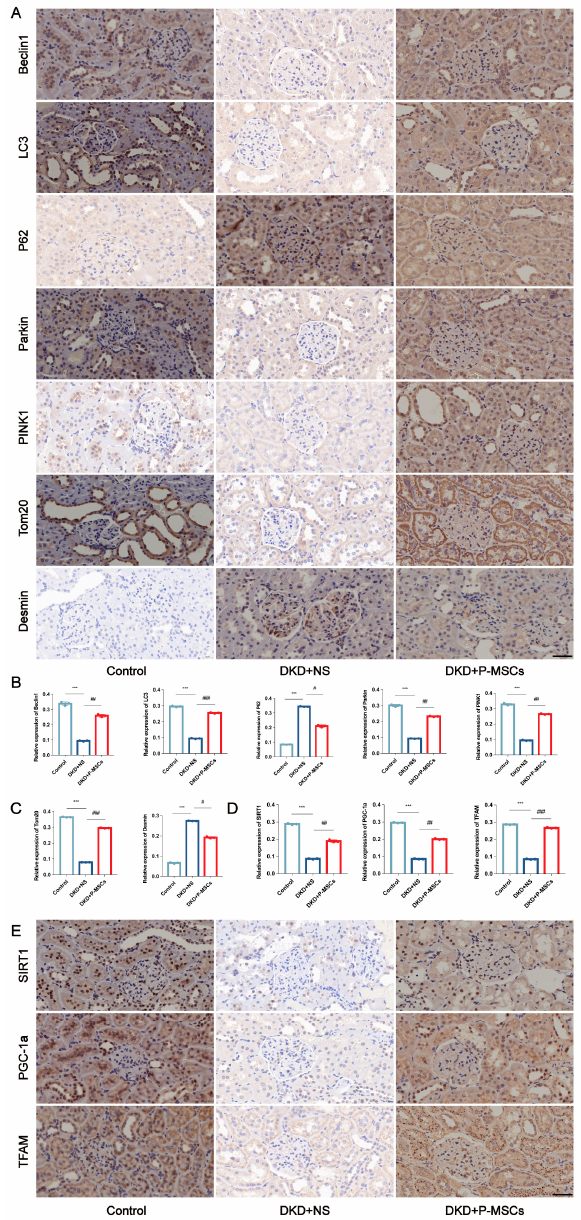
Figure 8. P-MSCs ameliorated STZ-induced podocyte injury and PINK1/Parkin-mediated mitophagy in DKD rats. ( A – C ) Immunohistochemical analysis of Beclin1, LC3, P62, Parkin, PINK1, and Tom20, as well as Desmin in DKD rats (Magnification, 400 × ). ( D , E ) Immunohistochemical analysis of SIRT1, PGC-1a, and TFAM in DKD rats (Magnification, 400 × ). Scale bars: 40 µ m for ( A , E ). n = 6 rats/group for ( A , E ). Values are expressed as the mean ± SD. *** p < 0.001 vs. control, # p < 0.05, ## p < 0.01, and ### p < 0.001 vs. DKD +